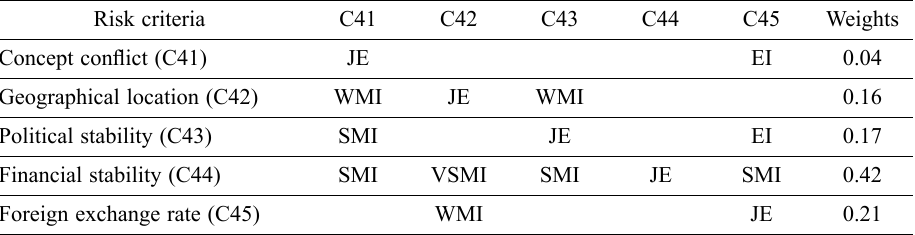
Table 7. Local weights and pairwise comparison matrix of risk (C4) sub-criteria